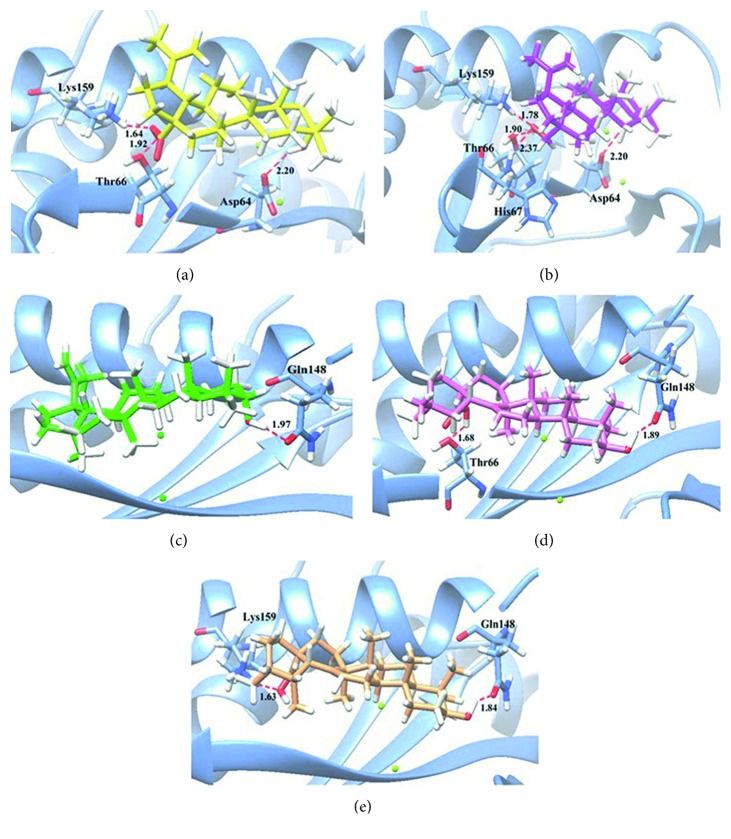
Molecular docking of the isolated compounds with HIV-1 IN. The ribbon model shows the backbone of the HIV-1 IN catalytic domain with all interacting amino acid residues shown as stick models and colored by heteroatoms. H-bond interactions are shown as red dashed lines and represent bond length in angstroms (Å). Mg2+ ions are shown as green balls. (a) Betulinic acid (1), (b) betulin (2), (c) lupeol (3), (d) oleanolic acid (4), and (e) ursolic acid (5).